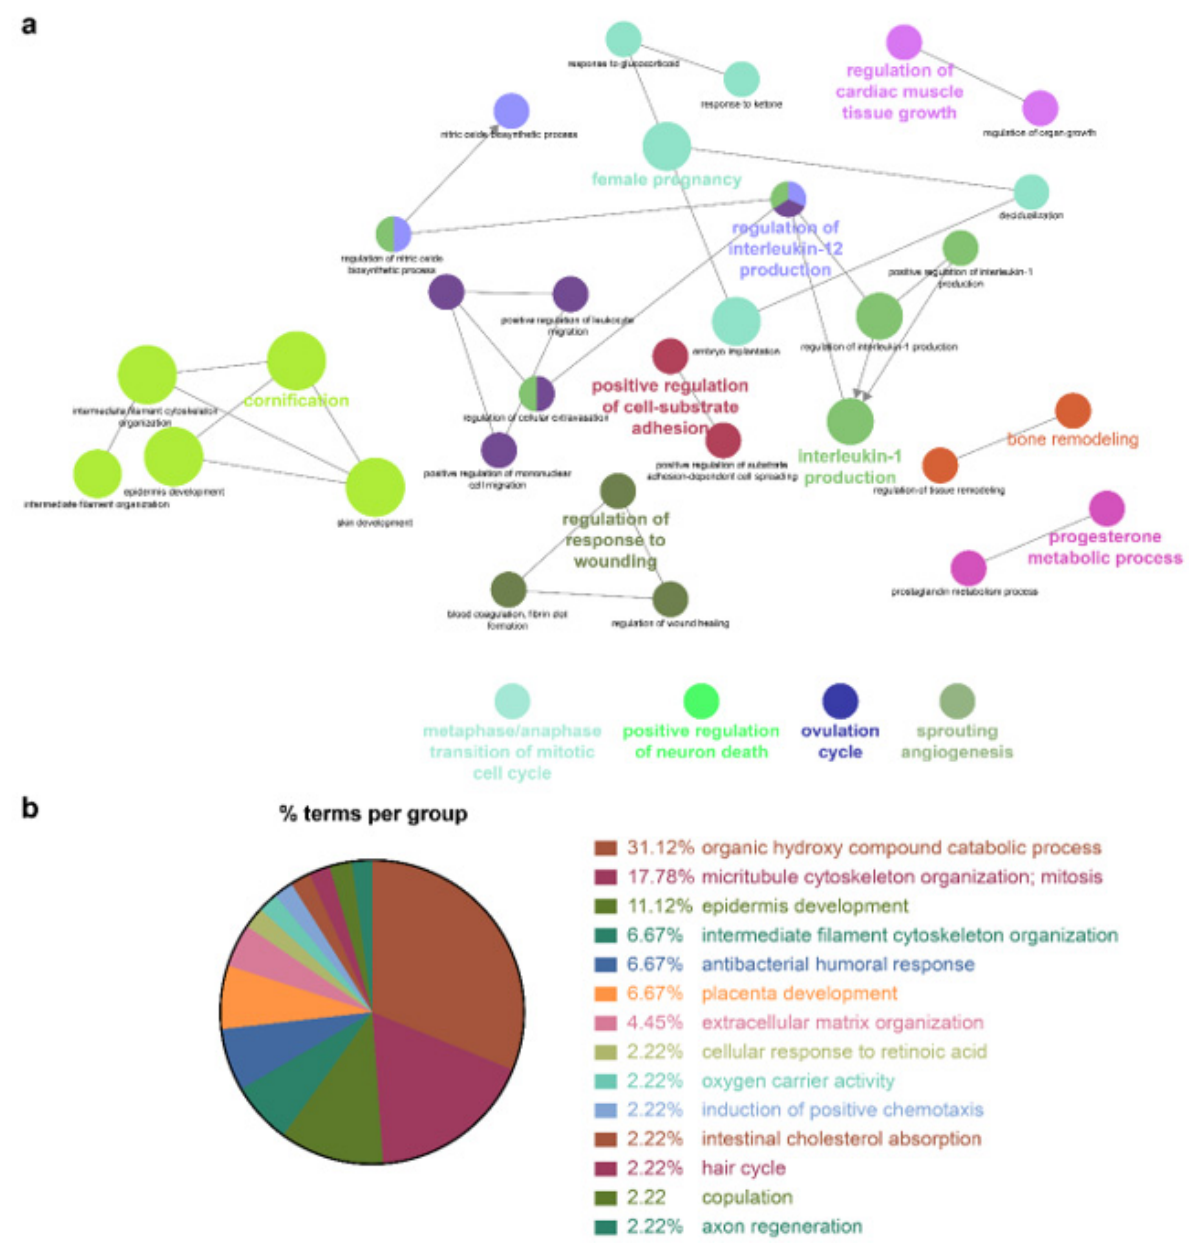
Figure 6. GO enrichment and pathway analysis of LUSC features. ( a ) Enriched GO “Biological Process” terms of LUSC were grouped based on shared genes (Kappa score threshold = 0.4). Enriched terms by p value corrected with Bonferroni were retained as the functional description. The node size is proportional to the degree of significance. ( b ) % terms per group represents the proportion of GO terms in the LUSC features.